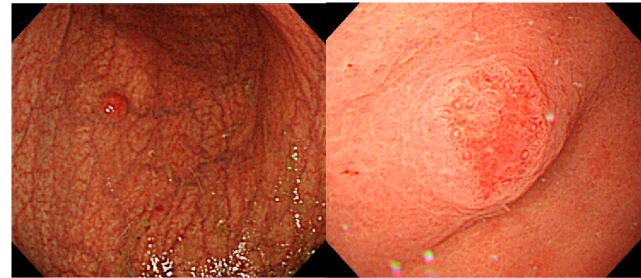
Figure 7. Images of neuroendocrine tumors (NETs) with AIG.